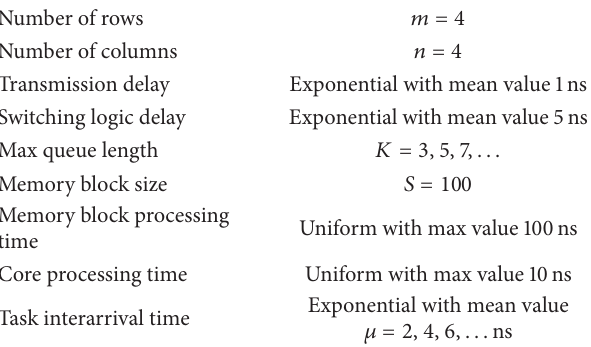
Table 1: Experiment